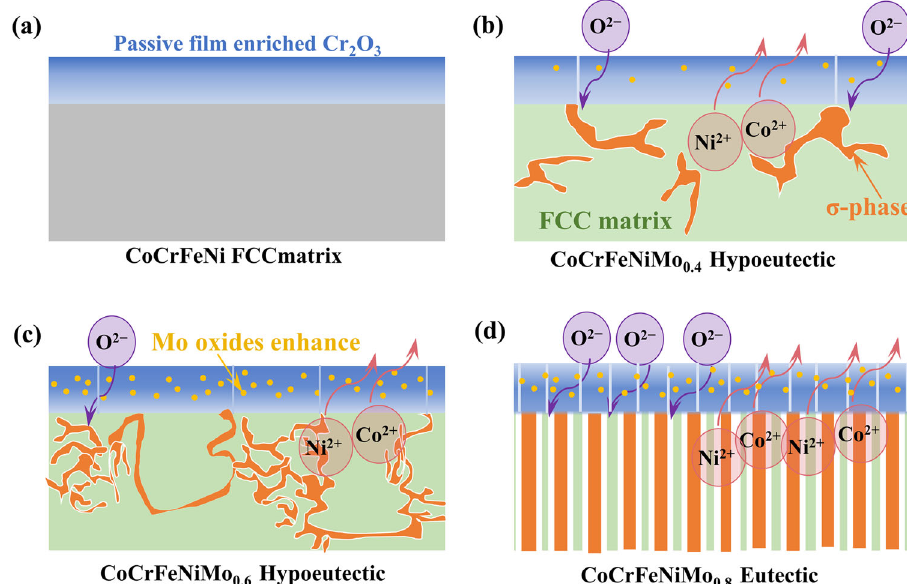
Fig. 14 The schematic diagram of galvanic corrosion and passivation. a Mo 0 , b Mo 0.4 , c Mo 0.6 , and d Mo 0.8